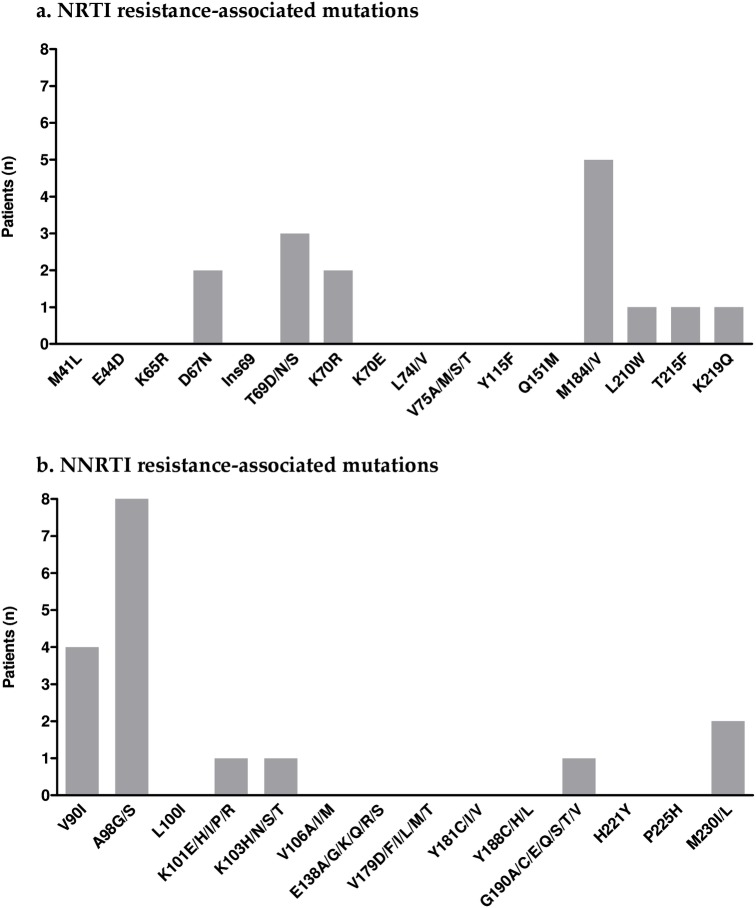
Distribution of NRTI (a) and NNRTI (b) resistance-associated mutations detected in the historical genotypic resistance tests of the patients.NNRTI: non nucleoside reverse transcriptase inhibitors, NRTI: nucleoside reverse transcriptase inhibitors.